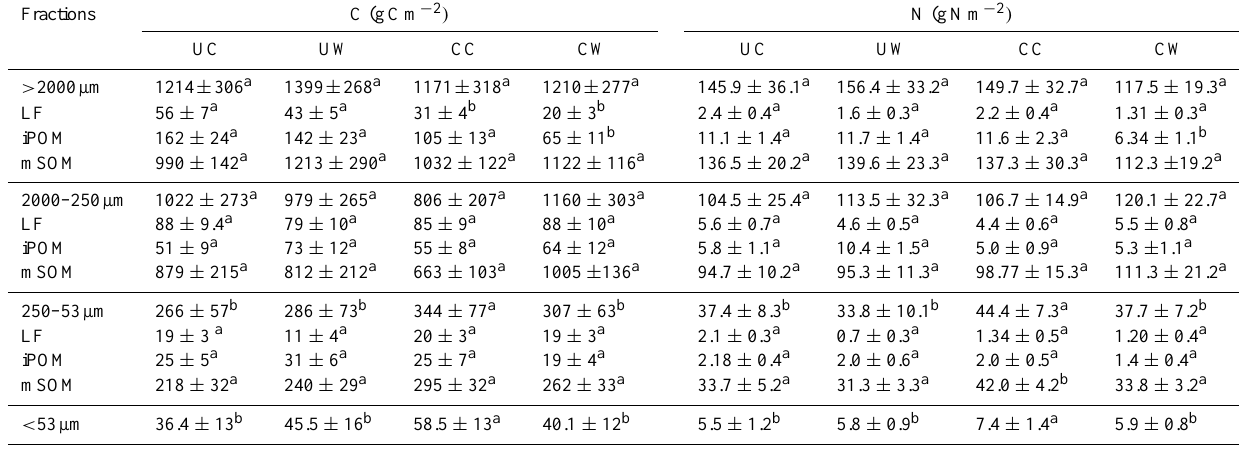
Table 4. Soil organic C and N content of soil fractions under four treatments after nine years of warming and clipping. Data are expressed as mean ± SE, n = 6. Different letters indicate statistical significance at P < 0 . 05 among the four treatments. See Table 3 for abbreviations.